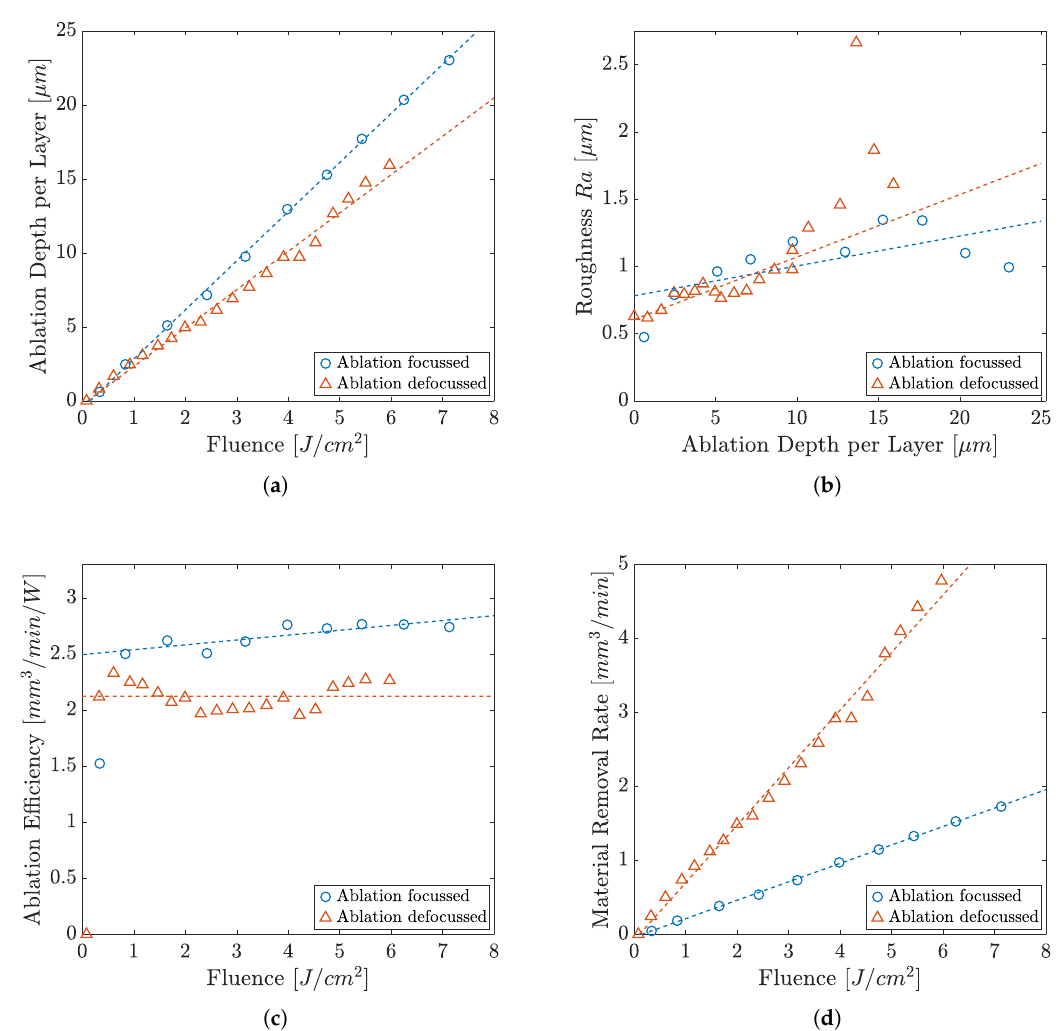
Figure 10. Comparison of the removal values of COC at UV with different focus positions: ( a ) material removal, ( b ) roughness, ( c ) removal efficiency, ( d ) removal rate plotted on